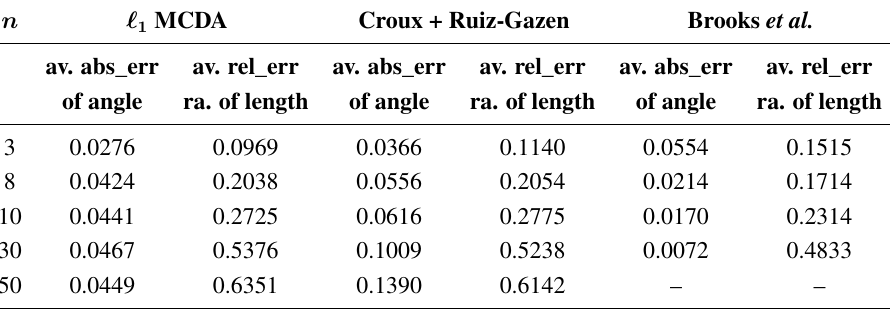
Table 4. The results of (cid:96) MCDA and Robust PCAs for one Student t distribution with 10% 1 artificial